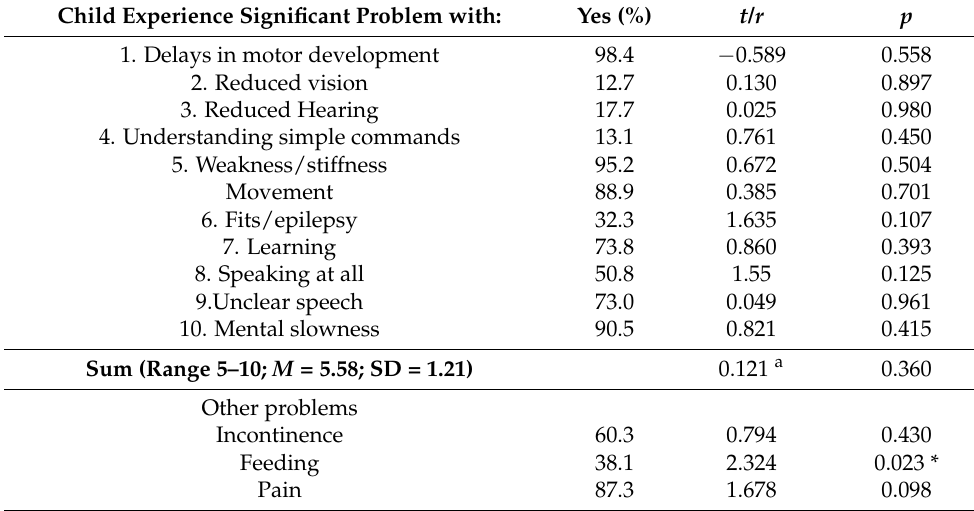
Table 2. Ten Questions Screen tool for disability and relationship to the